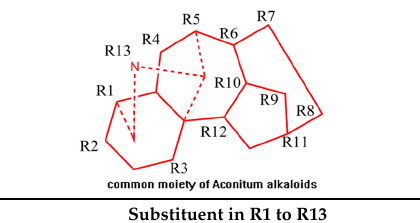
Table 4. Structure of Aconitine alkaloids with toxic activity.